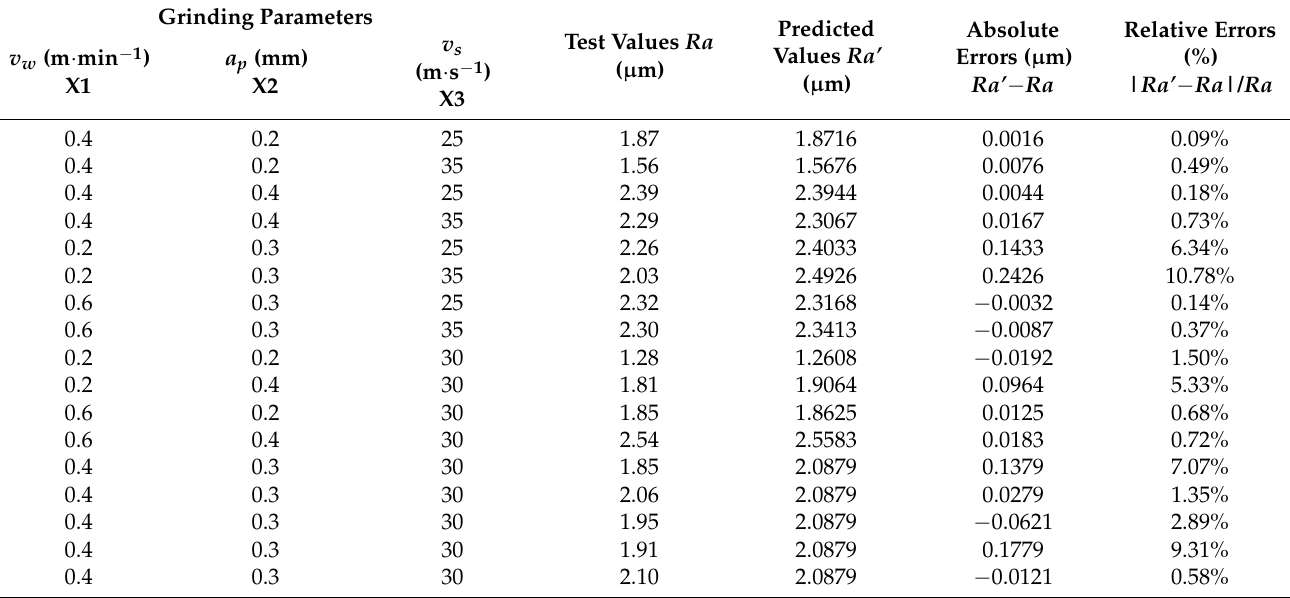
Figure 10. BP neural network model flow chart. Table 7. Test values, predicted values, absolute errors and relative